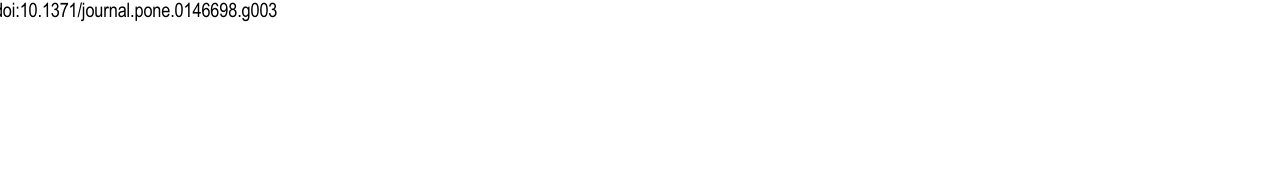
Fig 3. Comparison between the model value and real value for four test data sets for DFMGEP-FR, parallel GEPSA and centralized